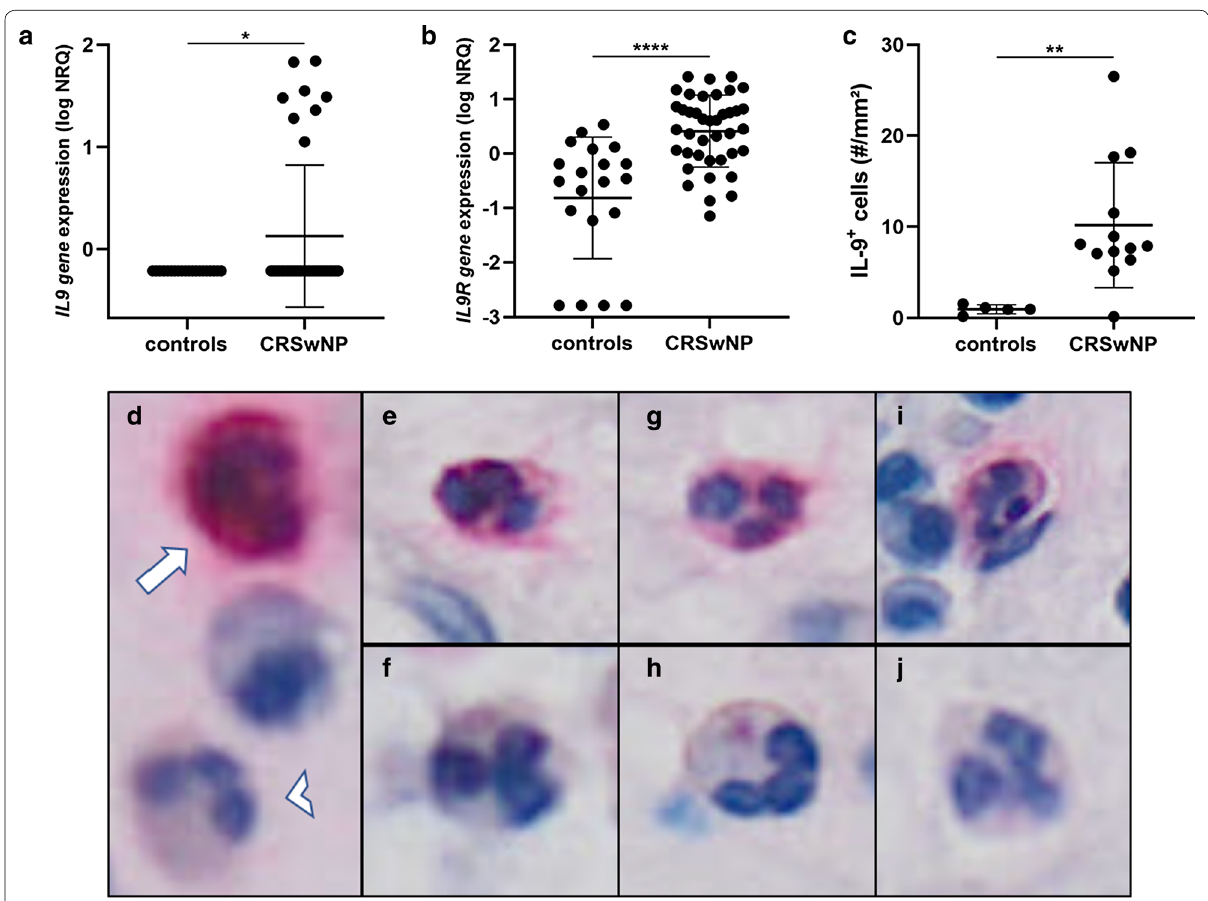
Fig. 1 IL9 – IL9R gene expression and numbers of IL-9 + cells are increased in CRSwNP compared to controls. a IL9 and b IL9R gene expression were significantly (resp. p < .05 and p < .0001) increased in tissue of CRSwNP (n numbers of IL-9 + cells were observed in tissue of CRSwNP (n quantity (NRQ). d IL-9 + neutrophil (arrow) and IL-9 − neutrophil (arrowhead) located near each other in the same patient. Both IL-9 + neutrophils ( e , g , i ) and IL-9 − neutrophils ( f , h , j ) were observed in patients with CRSwNP. Levels of statistical significance are expressed as * p < .05, **p < .01, ***p < .001 and ****p <